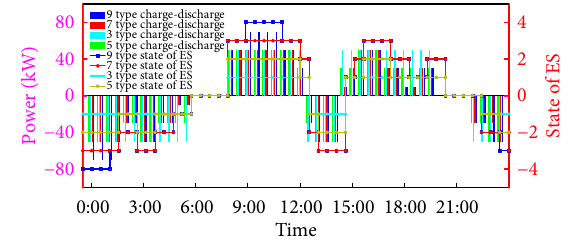
Fig. 6 Operating characteristics of EB.